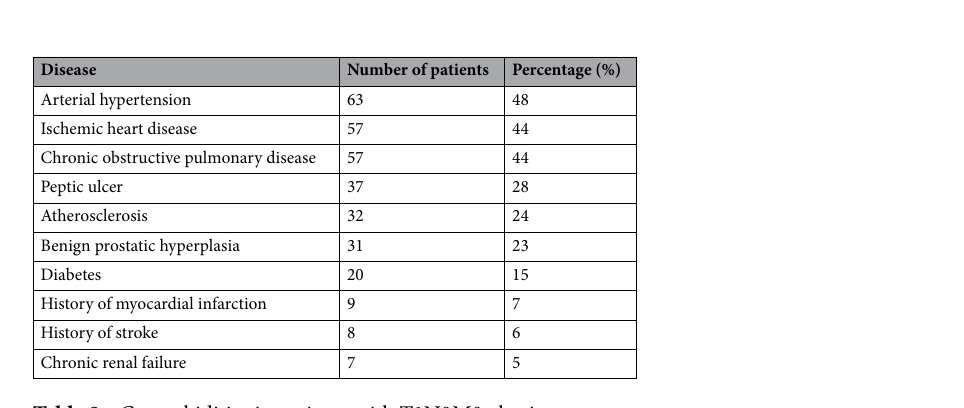
Table 8. Comorbidities in patients with T1N0M0 glottic cancer.